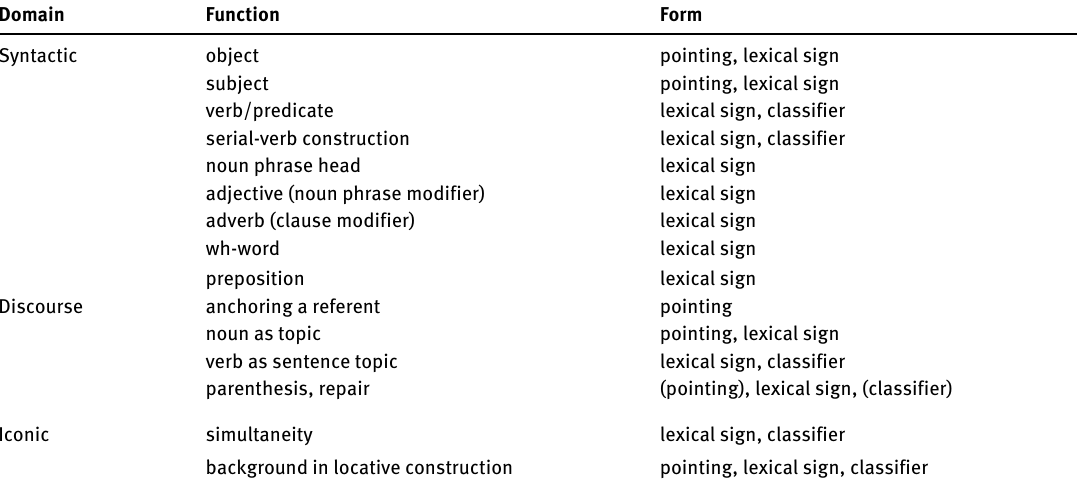
Table 4 Forms and functions of holds in RSL and